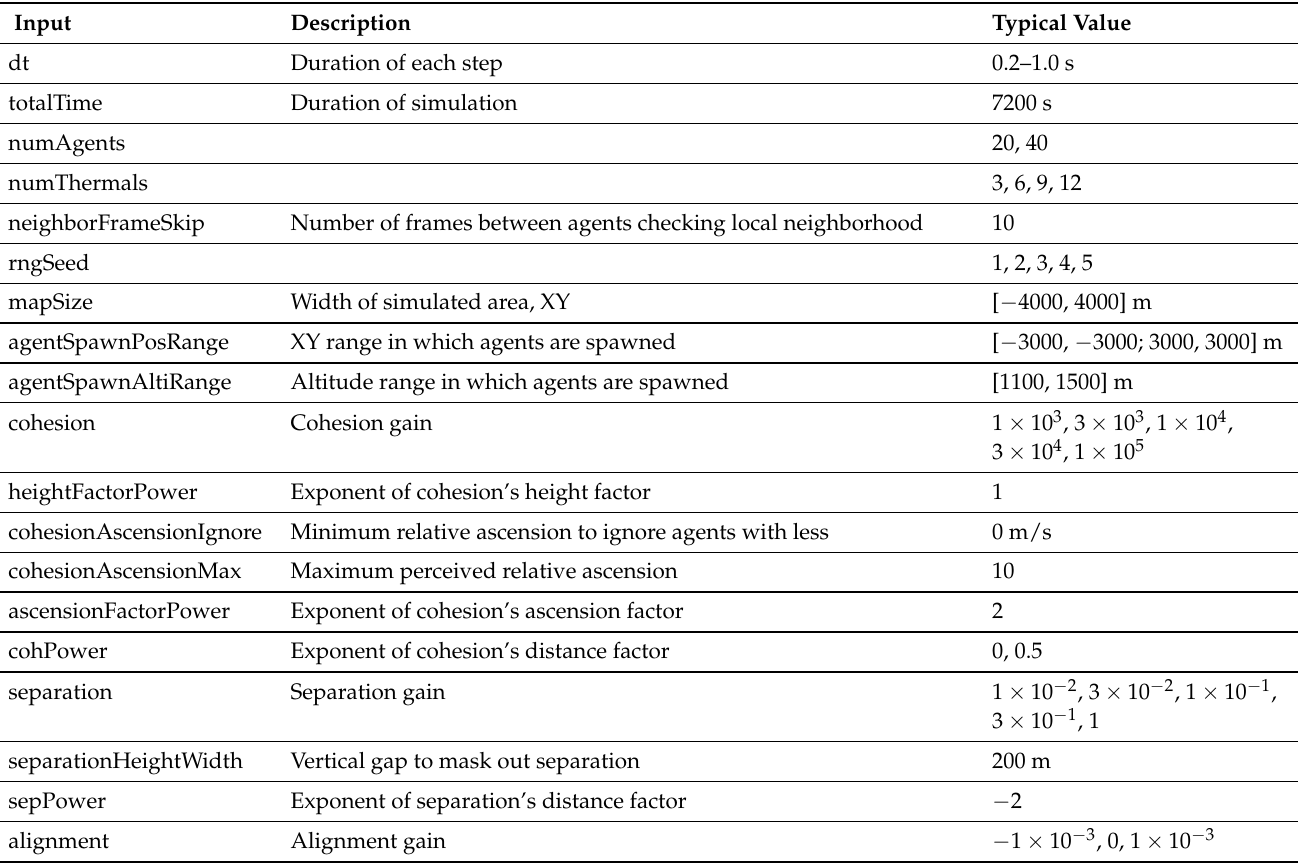
Table A1. Exhaustive list of parameters used to define a simulation. Due to computational limitations, most variables were held